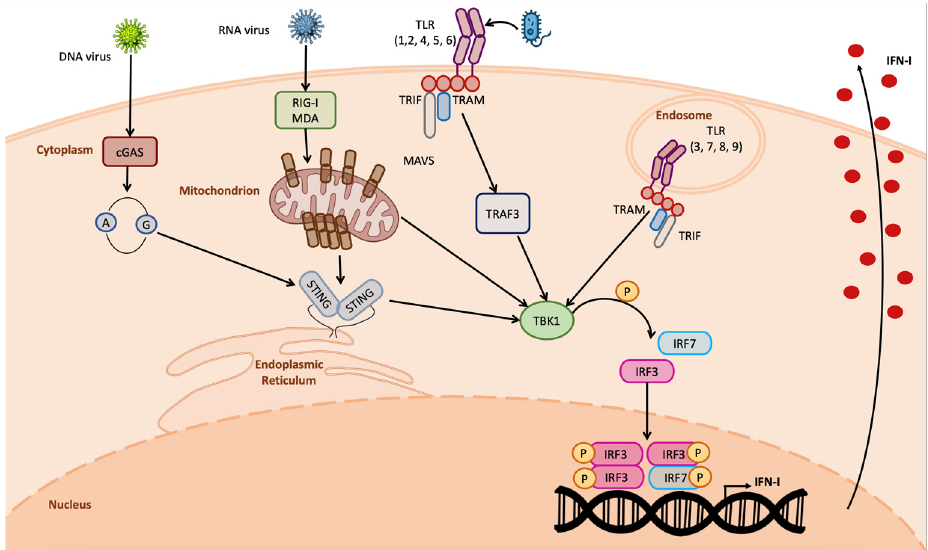
Figure 1. Overview on IFN-I induction by pathogens. DNA viruses are detected by cGAS owing to the DNA release in the cytosol, inducing STING dimerization and IFN-I transcription; RNA viruses are detected by RIG-I and MDA5, inducing MAVS multimerization in the mitochondrial membrane, leading to IFN-I production; TLRs are activated by the detection of bacterial PAMPs, inducing IFNs. All of these pathways require TBK1 kinase activity.